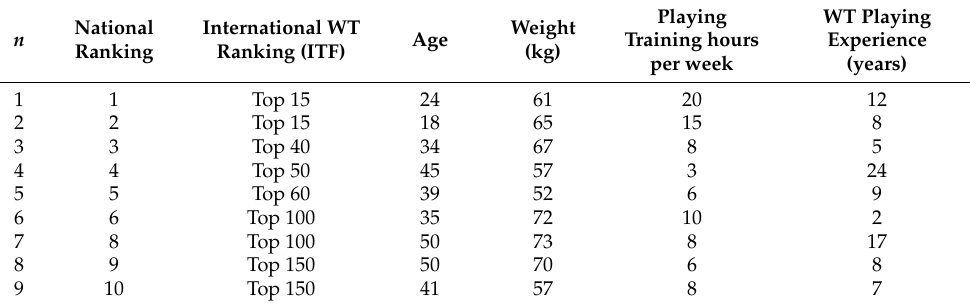
Table 1. Characteristics of the sample of wheelchair tennis players participating in the